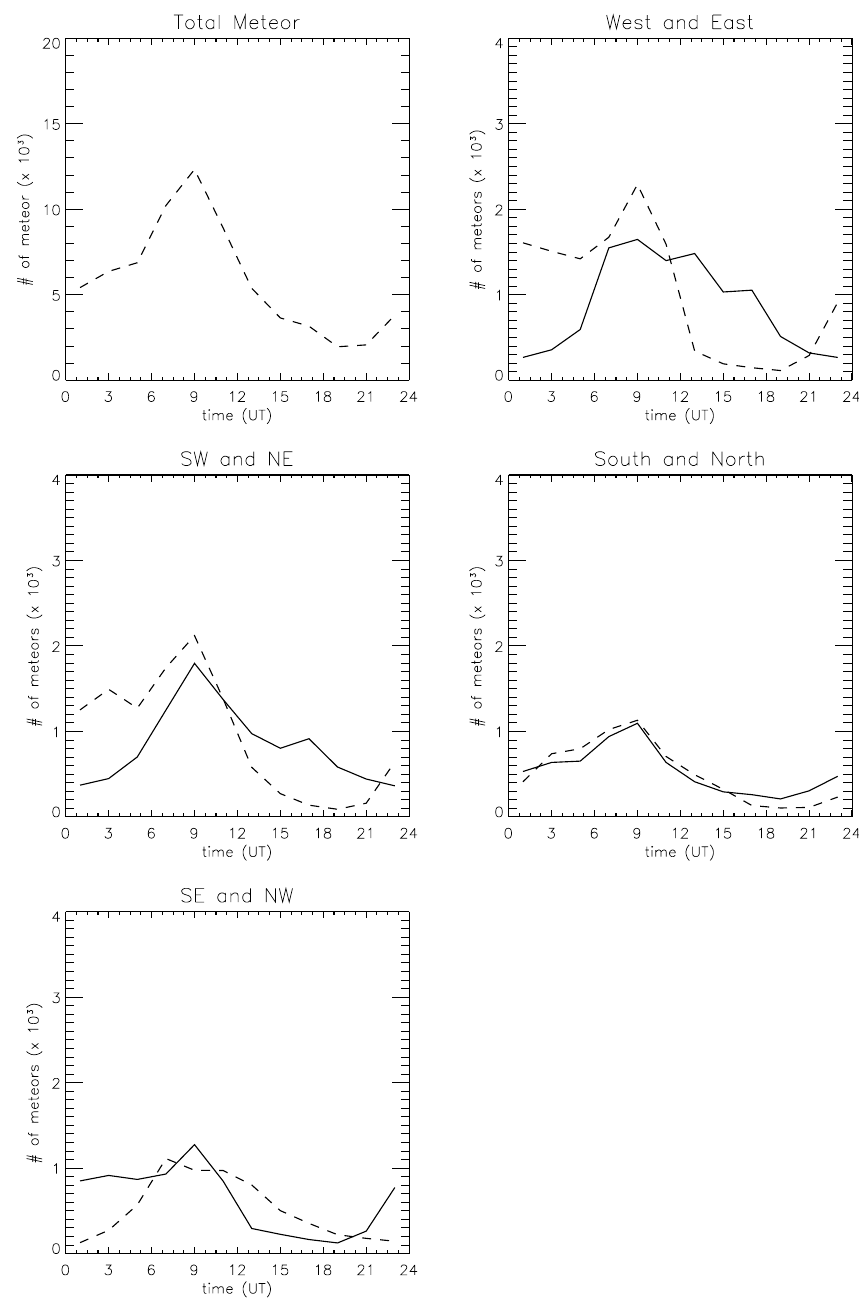
Fig. 6. As in Fig. 1 for Cachoeira Paulista during January 2005.